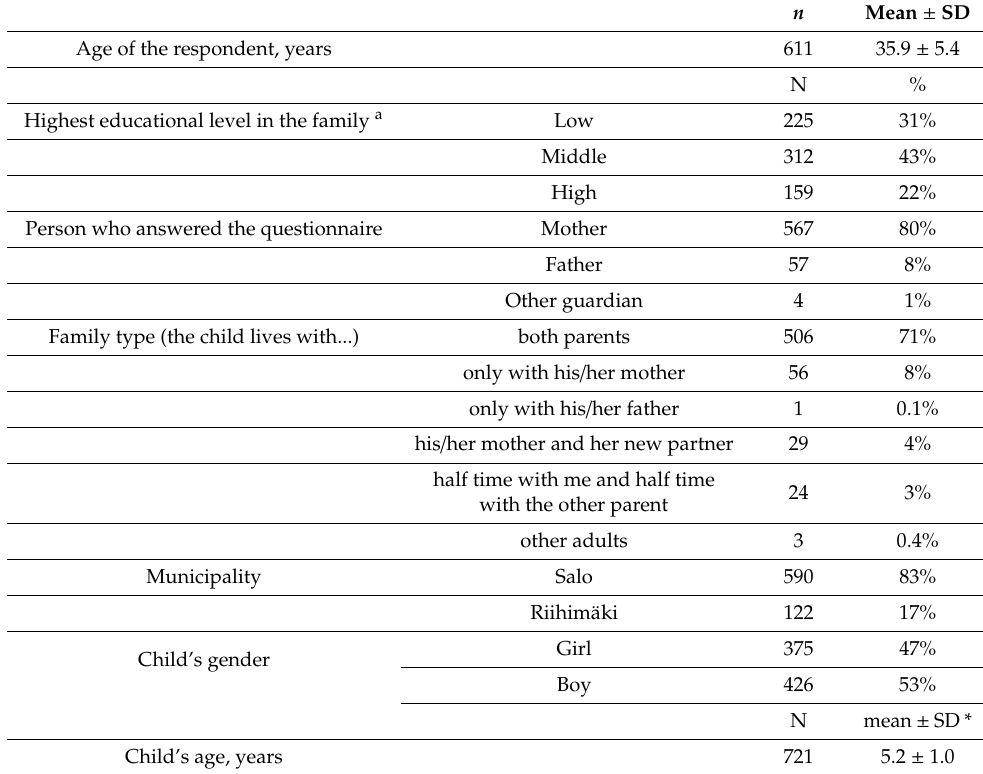
Table 2. Characteristics of the participants at